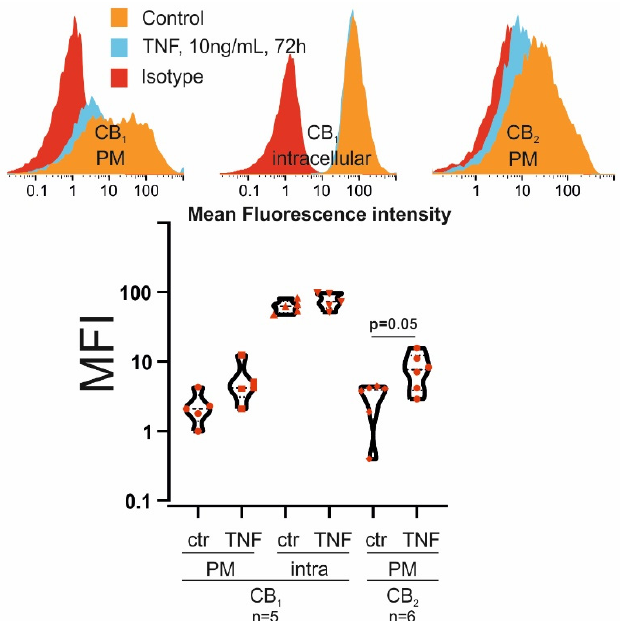
Figure 1. Flow cytometric detection of CB 1 and CB 2 in and on RASF. RASF were incubated with TNF (10 ng/mL) for 72 h, and CB 1 and CB 2 levels were determined thereafter. Upper panel: histogram; detection of CB 1 at the plasma membrane (PM) and intracellularly and CB 2 at the plasma membrane. Lower panel: violin plots; quantification of CB 1 and CB 2 . t –test was used for comparisons. p = 0.05 was the level of significance.